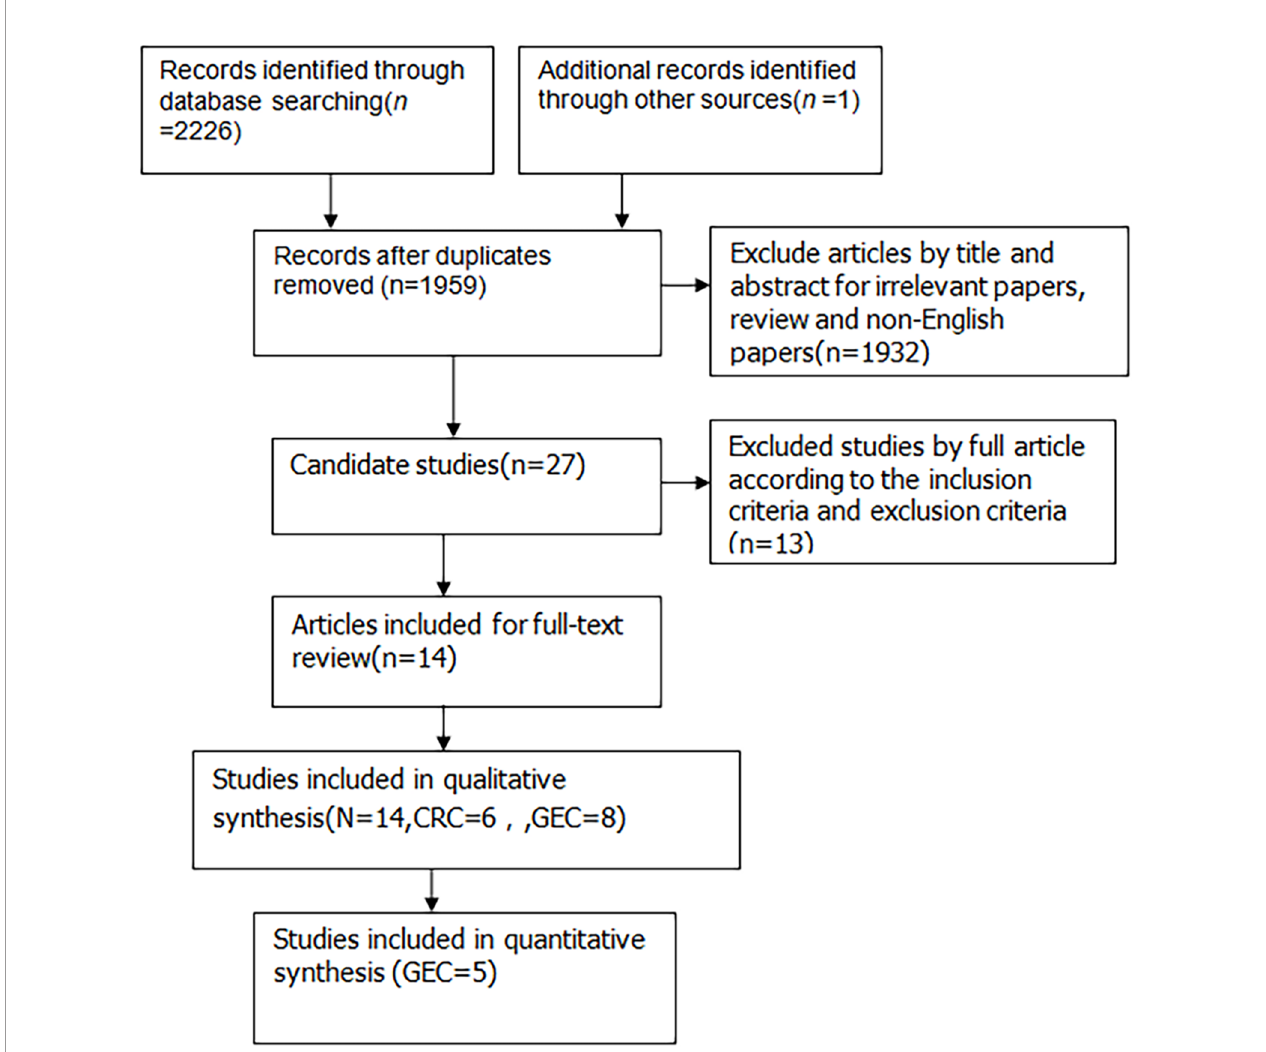
FIGURE 1 | Flowchart of study selection for this meta ( Table 2 ). Kumar et al. (35) applied SIFT-MS to quantify the